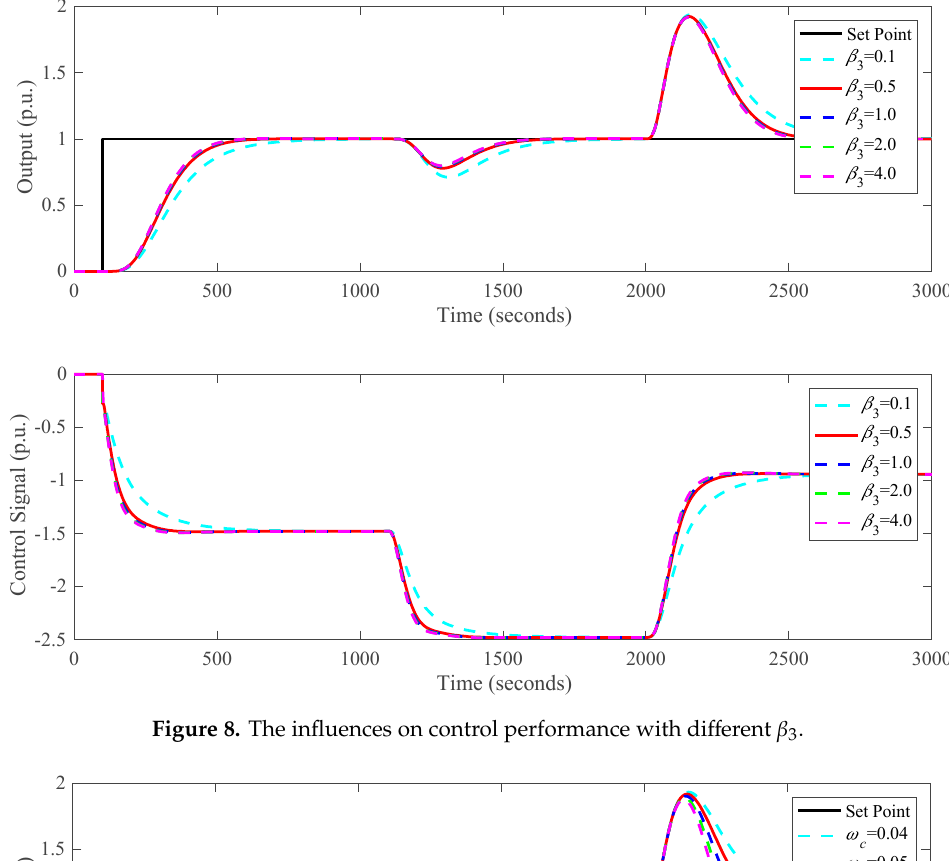
Figure 8. The influences on control performance with different β 3 .